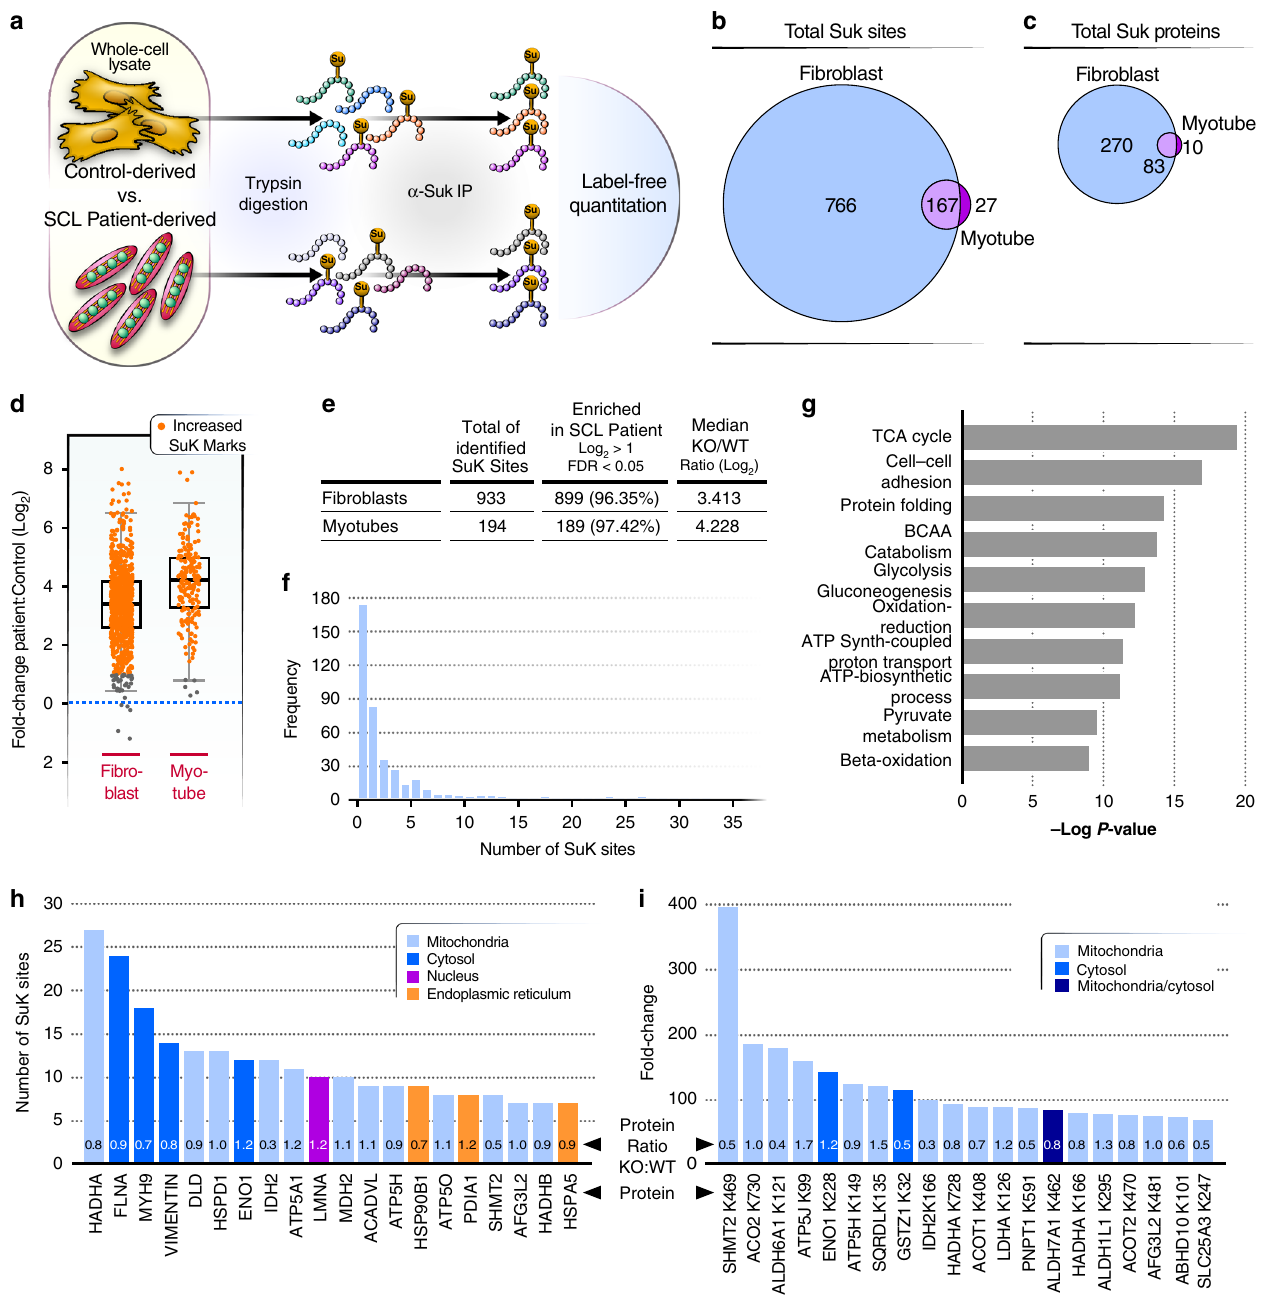
Fig. 2 Proteomics analysis of protein lysine succinylation. a Work fl ow for label-free proteomics quantitation of succinyl-lysine residues in whole-cell lysates of fi broblasts and myotubes from SCL patients and controls. Samples were trypsin-digested. Succinylated lysines were enriched by immune af fi nity and analyzed by mass spectrometry ( n = 2 control, n = 3 SCL patient-derived fi broblasts; n = 2 control, n = 1 patient-derived myotubes; A technical replicate of patient-derived myotube samples was used). b Venn diagram of total number of succinylated lysine sites identi fi ed in fi broblasts and myotubes. c Venn diagram of total number of proteins carrying succinyl-lysine sites. d Boxplot of fold-changes of succinyl-lysine mean intensities in fi broblasts and myotubes from patients compared to controls. Orange points indicate lysine marks enriched signi fi cantly more in patient samples, compared to controls. The boxplot shows the median, the fi rst to third quartile, the 1.5x interquartile ranges, and outliers. e Table of identi fi ed SuK sites in fi broblasts and myotubes showing total numbers of SuK sites, numbers of SuK sites signi fi cantly enriched in SCL patient samples, and the median values of log 2 - transformed ratios of patient-derived samples, compared to that from control cells. f Distribution of frequencies of succinylated lysine PTMs per detected protein. More than half of the proteins contain only one succinylated lysine. Oher proteins carry more than one SuK mark with a maximum of 27 SuK PTMs. g GO biological process term enrichment analysis of hyper-succinylated proteins from the fi broblast samples. Statistical signi fi cance was determined using fi sher exact test. h Barplot of the 20 proteins with the highest numbers of SuK marks identi fi ed in our analysis. Highly succinylated proteins are found in different cellular compartments, including mitochondria, the nucleus, the endoplasmic reticulum and the cytosol. Protein ratio indicates levels of proteins in SCL patient-derived cells vs control cells. i Barplot of the 20 most dynamically affected succinylation marks in the absence of SUCLA2 as detected in this analysis. Source data are provided as a Source Data fi le. SuK = succinyl-lysine; TCA = tricarboxylic acid; BCAA = branched chain amino